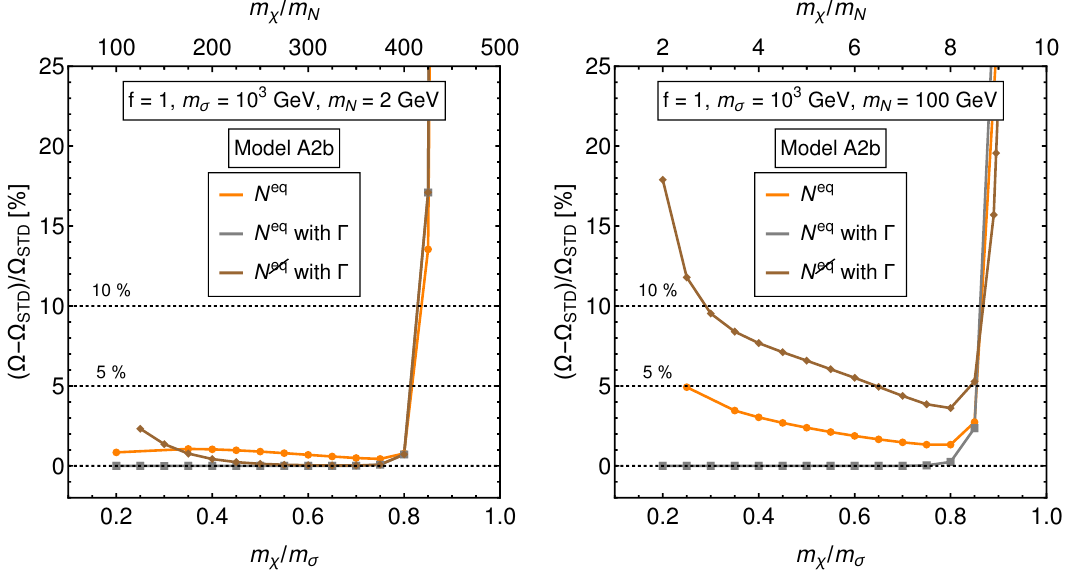
Figure 6 . Measurement of the relative deviation in the relic abundance ( Ω ) and the standard approximation ( Ω ) calculated in different cases for Model A2b: solving the full set of BEqs STD in eqs. (A.1)–(A.4) (brown line), setting N in equilibrium (orange line) and assuming also N in equilibrium but taking into account decays (grey line). We have fixed m 100 GeV in the left and right panels,